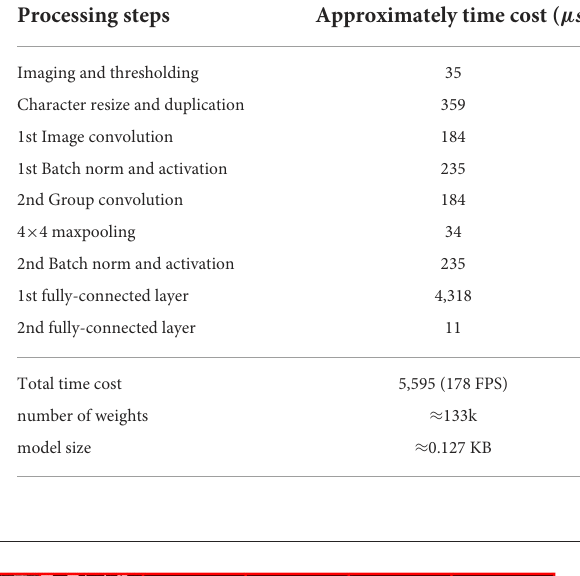
TABLE 2 Computation time breakdown CNN of a single branch.